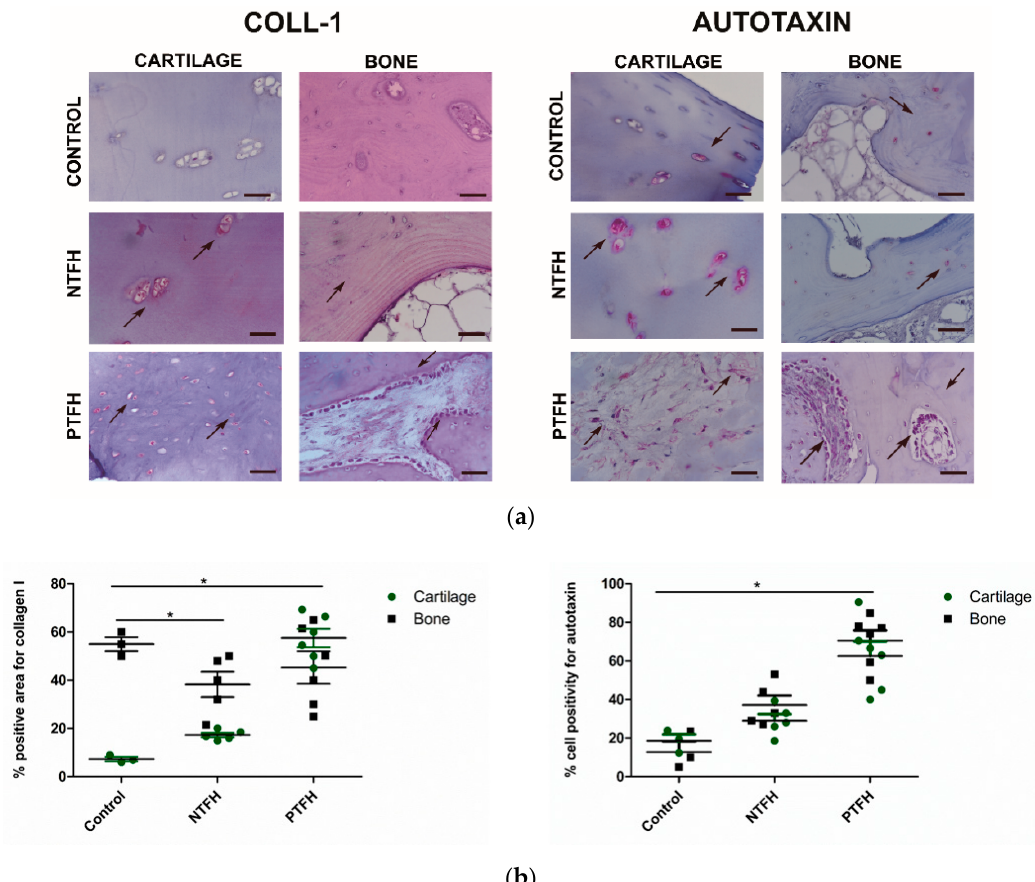
Figure 2. ( a ) Immunostaining for collagen type I and autotaxin of control, NTFH and PTFH groups. Scale bar: 50 µ m. Black arrows: positive areas for markers. ( b ) Graphical representation of quantitative measurements for collagen type I and autotaxin in control, NTFH and PTFH groups. Data are reported in a scatter plot graph with mean ± SD. Collagen type I: * p < 0.05: Control versus PTFH group; * p < 0.05 NTFH versus PTNH group. Autotaxin: * p < 0.05: Control versus PTFH group.